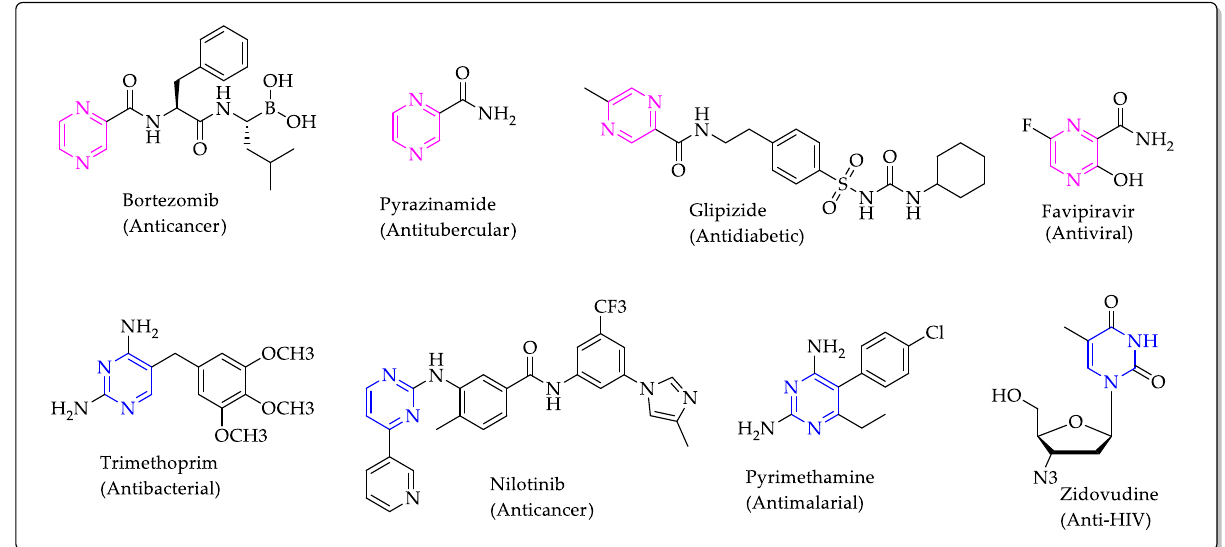
Figure 1. Chemical structures of selected drugs comprising pyrazine and pyrimidine scaffolds.